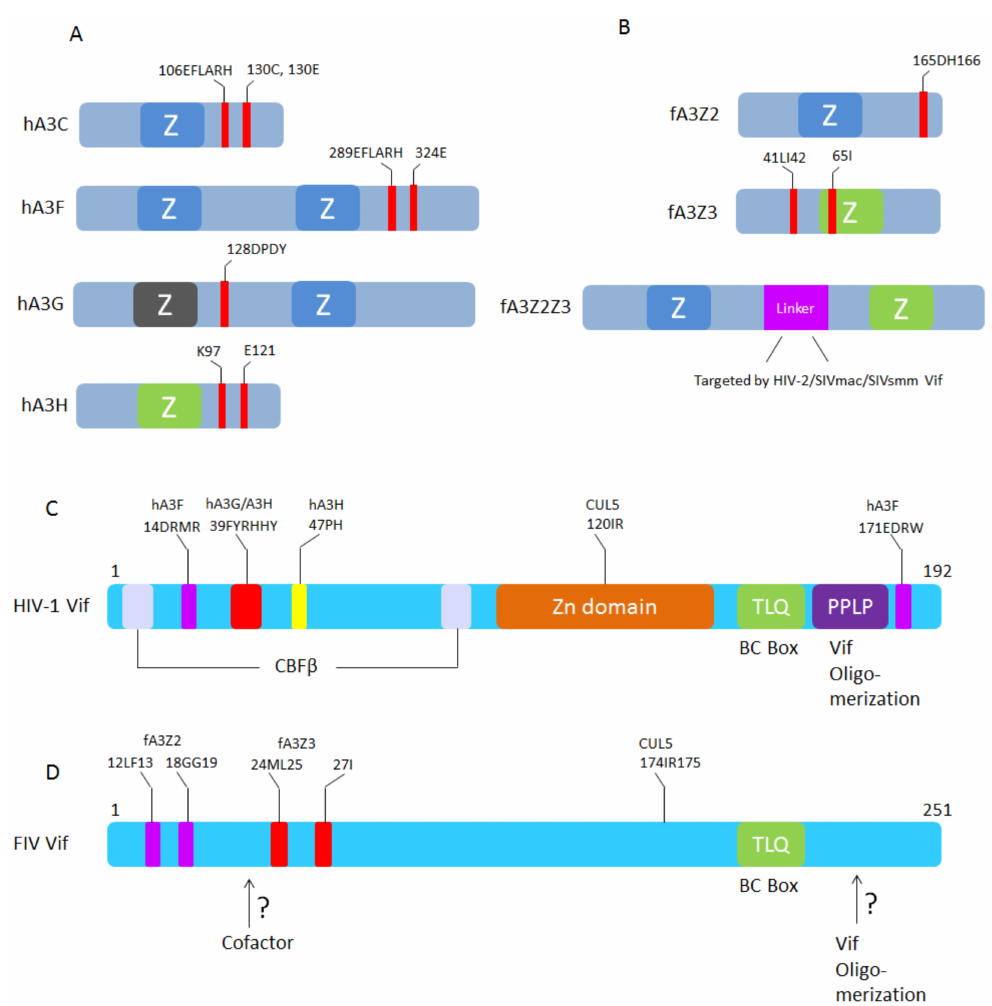
Figure 5. Schematic representation of A3-Vif interaction sites. ( A ) HIV-1 Vif binding sites in human A3C, A3F, A3G, and A3H [60,94–97]; ( B ) FIV, HIV-2, SIVmac, and SIVsmm Vifs binding sites in feline A3Z2, A3Z3, and A3Z2Z3, respectively [79]; ( C ) The human A3F, A3G, A3H, CUL5, CBF- β , and ElonginB/C binding sites in HIV-1 Vif (see review [98]); ( D ) The feline A3Z2, A3Z3, and CUL5 binding sites in FIV Vif [46]. FIV Vif domains that interact with additional cofactors and sites for oligomerization are not